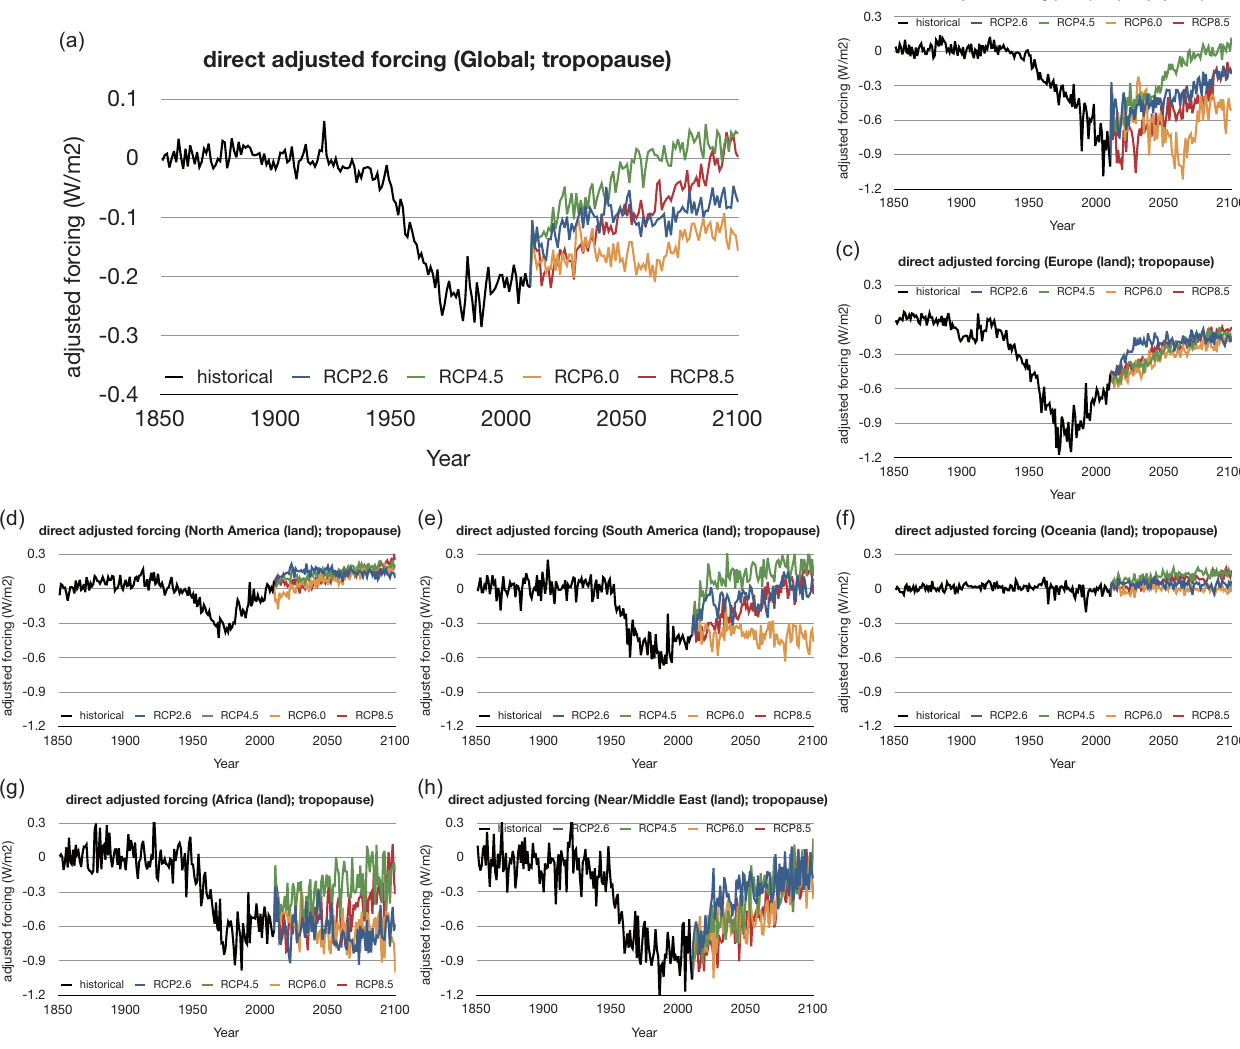
Fig. 7. Time series of annual and (a) global or (b) – (h) regional mean adjusted forcing due to the aerosol direct effect at the tropopause relative to the preindustrial experiment simulated by SPRINTARS. The regional mean values are only over land. The historical period is shown in black, and the four RCPs are shown in